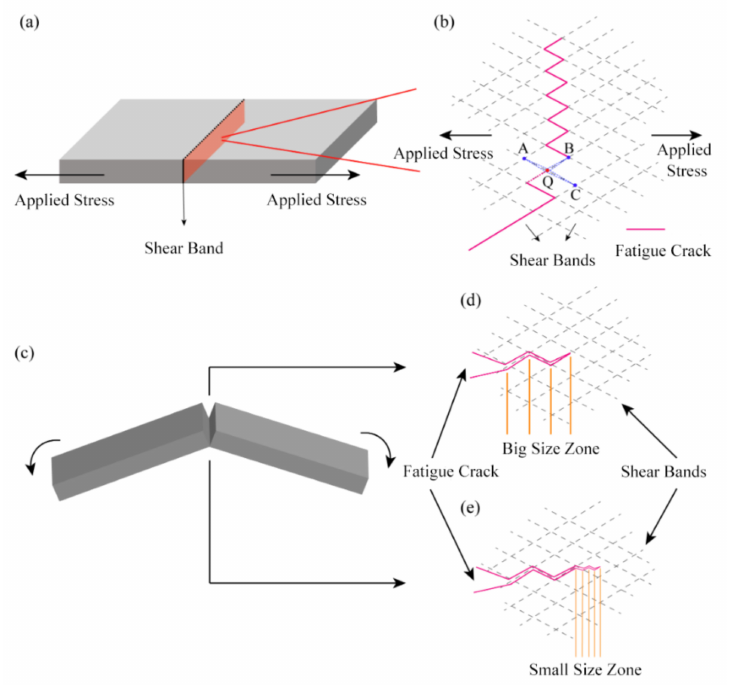
Figure 7. Fracture schematic diagram of the Mg 70 − x Zn 30 Ce x (x = 2, 4, 6 and 8 at.%) amorphous ribbon samples: ( a ) 3D schematic diagram of the ribbon stretching, ( b ) microscopic schematic diagram, ( c ) 3D schematic diagram of ribbon bending, ( d , e ) microscopic schematic diagrams of